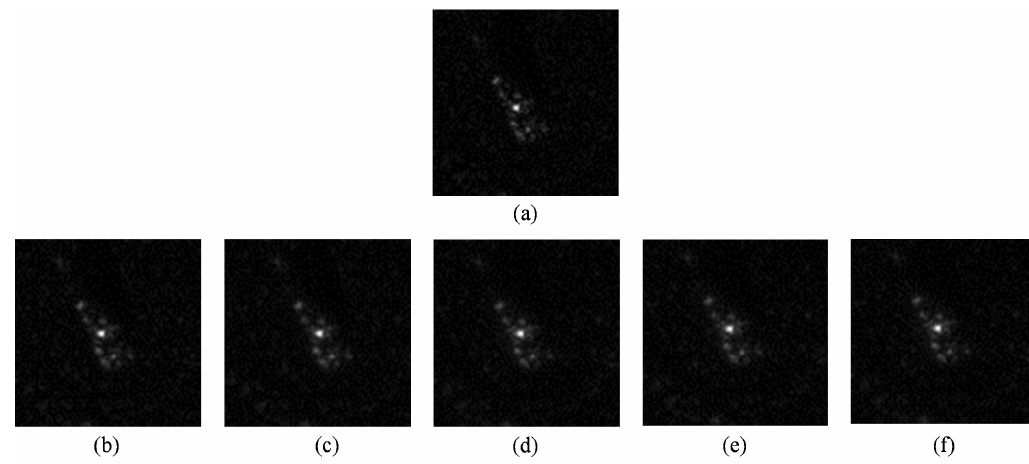
Figure 5. Training results of reconstruction pathway (baseline). ( a ) the input image; ( b – f ) the reconstruction images of five convolutional layers.